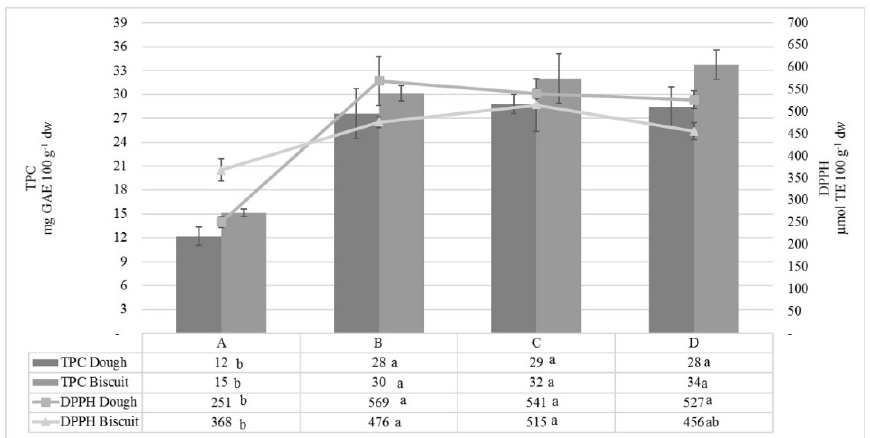
Figure 2. TPC values and antioxidant activity of dough and biscuit samples. Means within a row with different letters are significantly different by Tukey’s post-hoc with different letters are significantly different by Tukey ’ s post-hoc test. Abbreviation: ** Signifi- cance at p < 0.01.